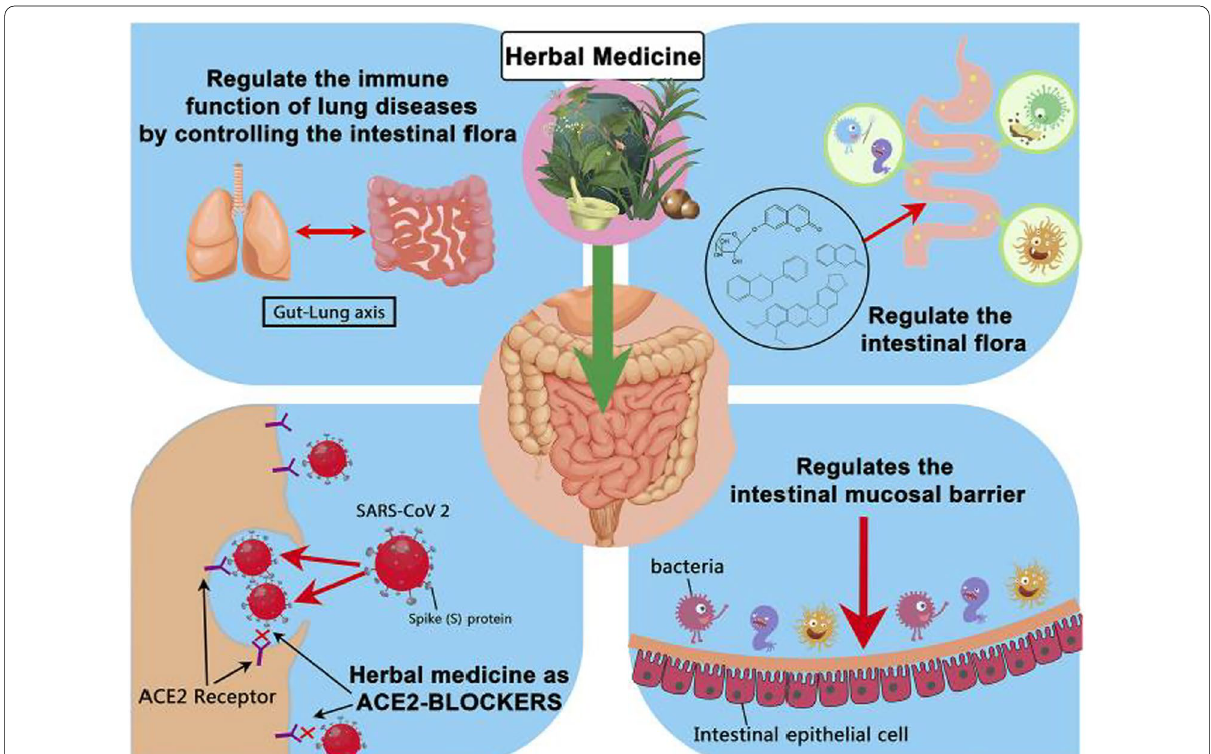
Fig. 2 Summary of possible ways in which herbal medicines can affect the prognosis of COVID-19 by regulating the intestinal flora (adapted from Chen et al.